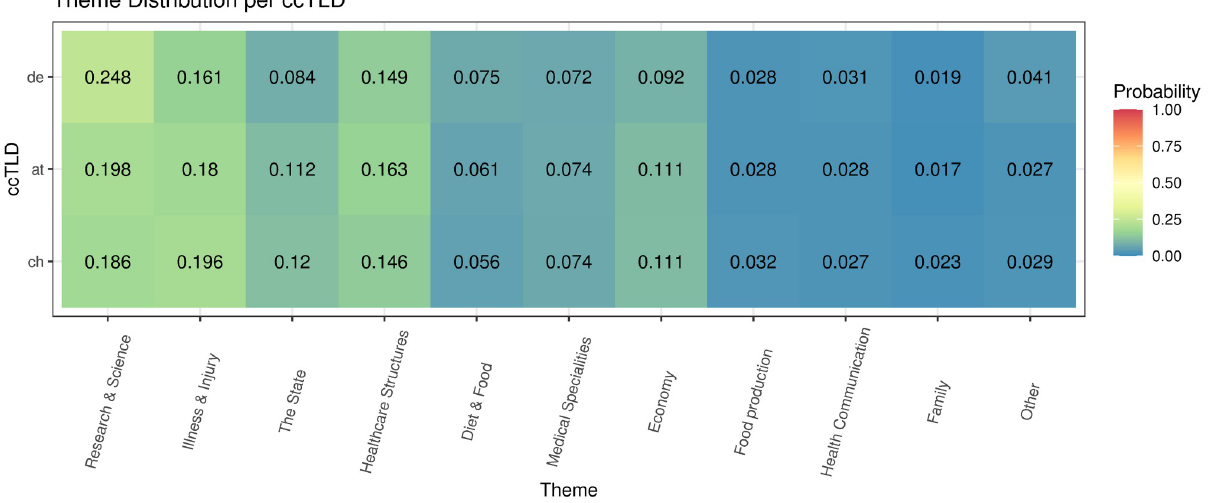
Fig 12. Theme distribution per